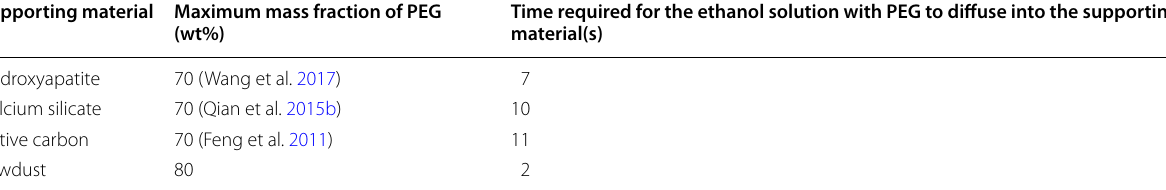
Table 2 Mass fraction of PEG and time required for the ethanol solution with PEG to diffuse into the supporting materials Supporting material Maximum mass fraction of PEG Time required for the ethanol solution with PEG to diffuse into the supporting (wt%)